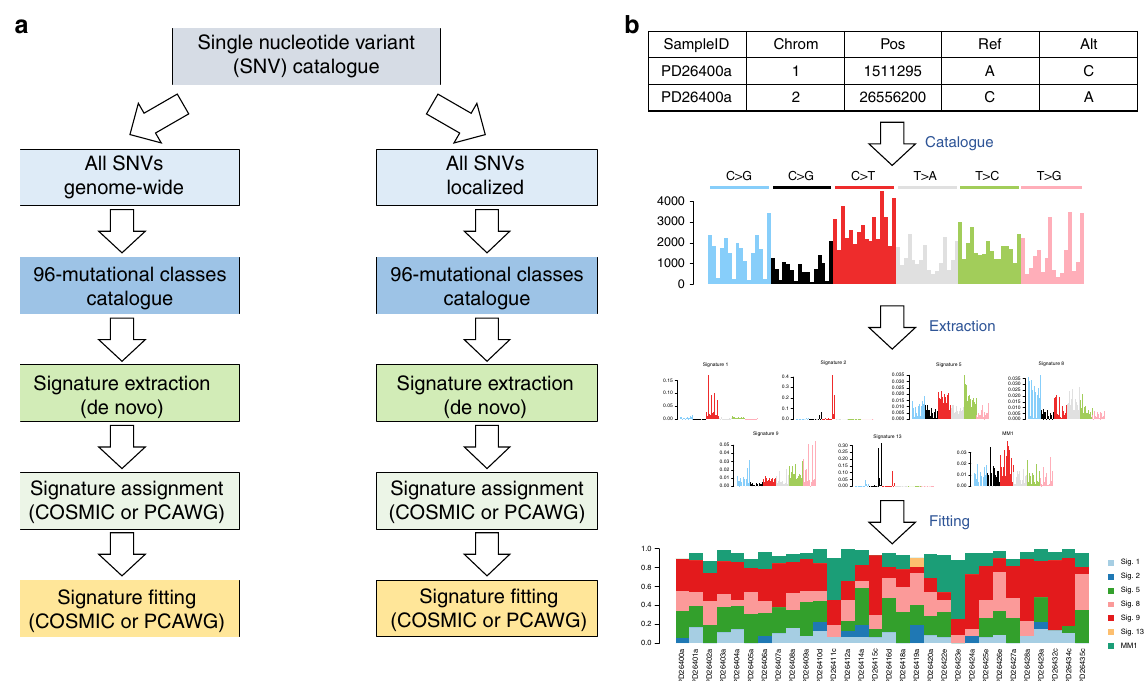
Fig. 8 Mutational Signature work fl ow. Our suggested work fl ow for mutational signature analysis for both genome-wide and clustered processes ( a ) and an example of its application on 30 MM WGSs ( b